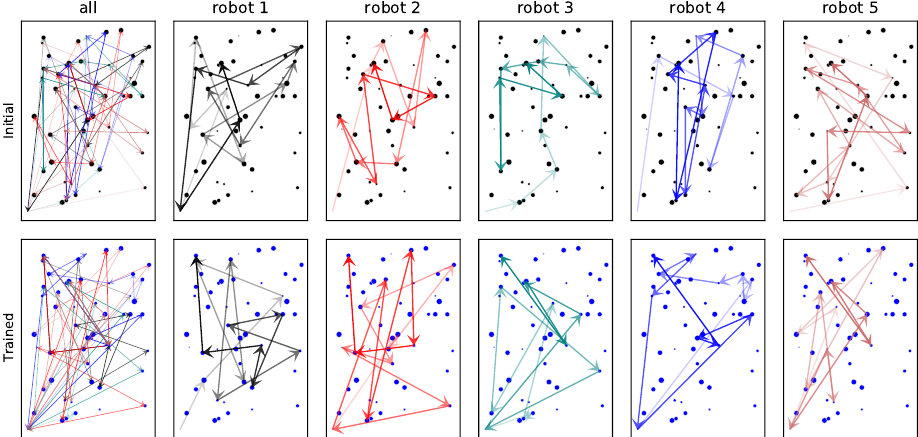
Figure 10. The disadvantage of end-to-end training. The first row represents the initial allocation of the PPO model and the second row represents the trained model. The makespan before training is 658 while the trained allocation has 412 makespan. Even though the makespan is reduced by 38%, the interpretation of the model is not trivial. The darker color represents the later